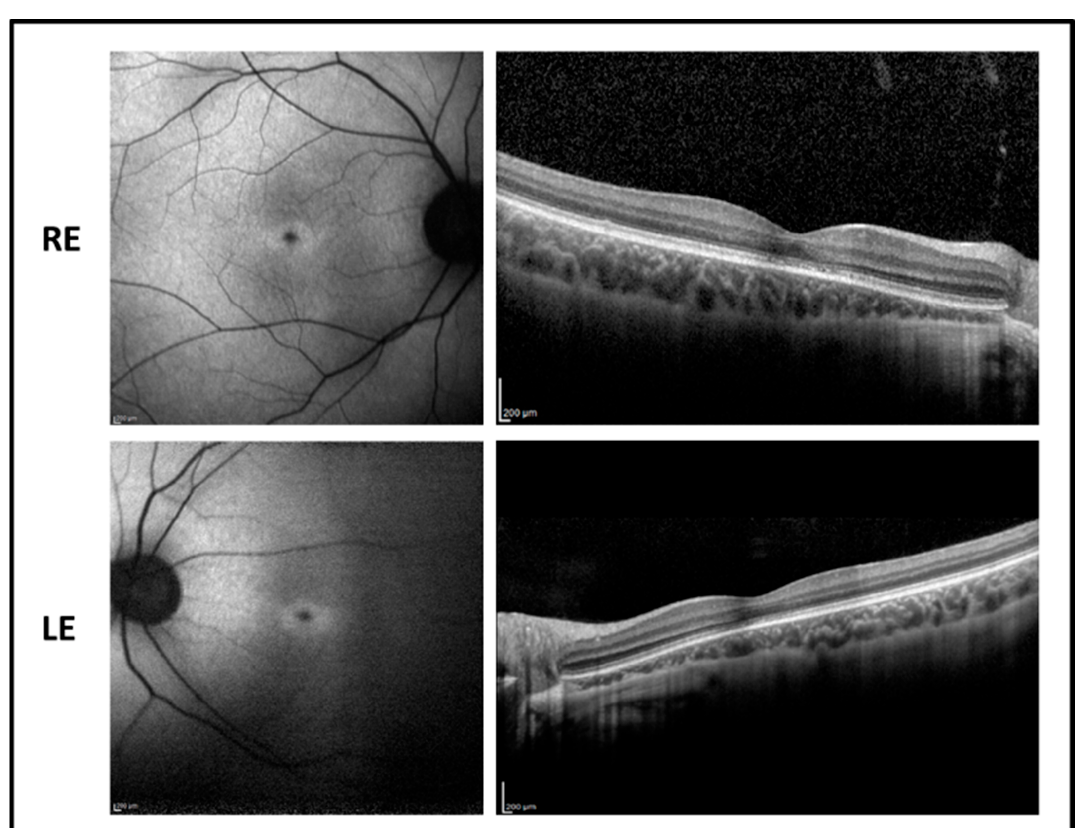
Figure 6. Fundus autofluorescence ( left side ) and OCT ( right side ) images of the right eye (RE) and left eye (LE) of patient 5 showing hyperfluorescent macular area with foveal hypofluorescence and foveal photoreceptor disruption with normal central macular thickness.